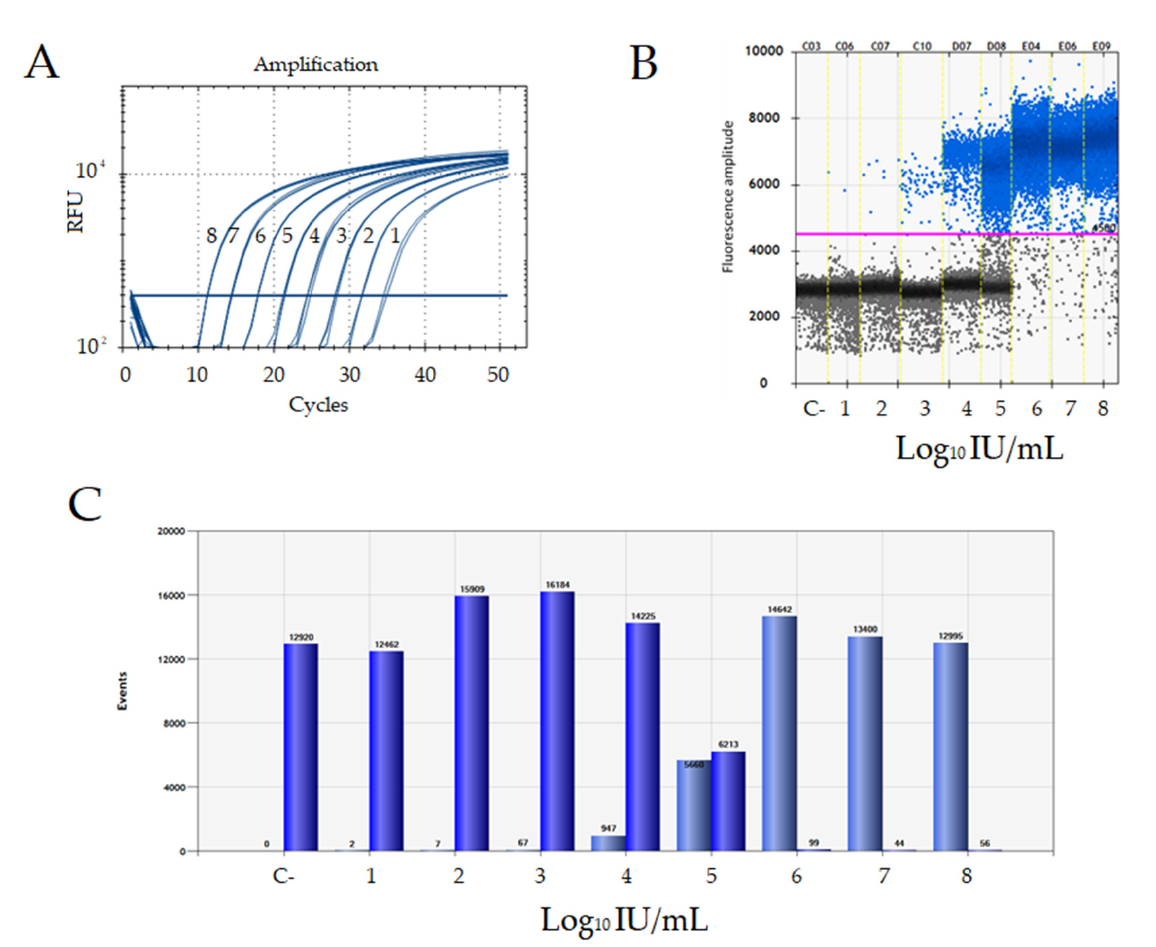
Figure 4. Determination of the assays linear range. ( A ) Amplification plot by RT-qPCR assay of a 10-fold dilution series (1 × 10 − 1 to 1 × 10 − 8 ) of a cDNA standard quantified in international units (IU) against the WHO-HDV international standard. Each dilution was tested in triplicate. Data are reported in Log 10 scale. ( B ) One-dimensional plot of a ddPCR assay for the detection of a 10-fold dilution series (1 × 10 − 1 to 1 × 10 − 8 ) of a cDNA standard quantified in international units (IU) against the WHO-HDV international standard. Data are reported in Log 10 scale. Individual droplets represent amplification of single or low copy number HDV-RNA template; blue droplets above the red threshold line are scored as positive, all black droplets below the red threshold line are scored as negative. Each column depicts the negative (black) and positive (blue) events for single ddPCR well. ( C ) ddPCR graphical representation of the droplet/events acquired by the droplet reader scored between positive droplet/events (light blue bars) and negative droplet/events (dark blue bars). Table 2. ddPCR accuracy of recovery.